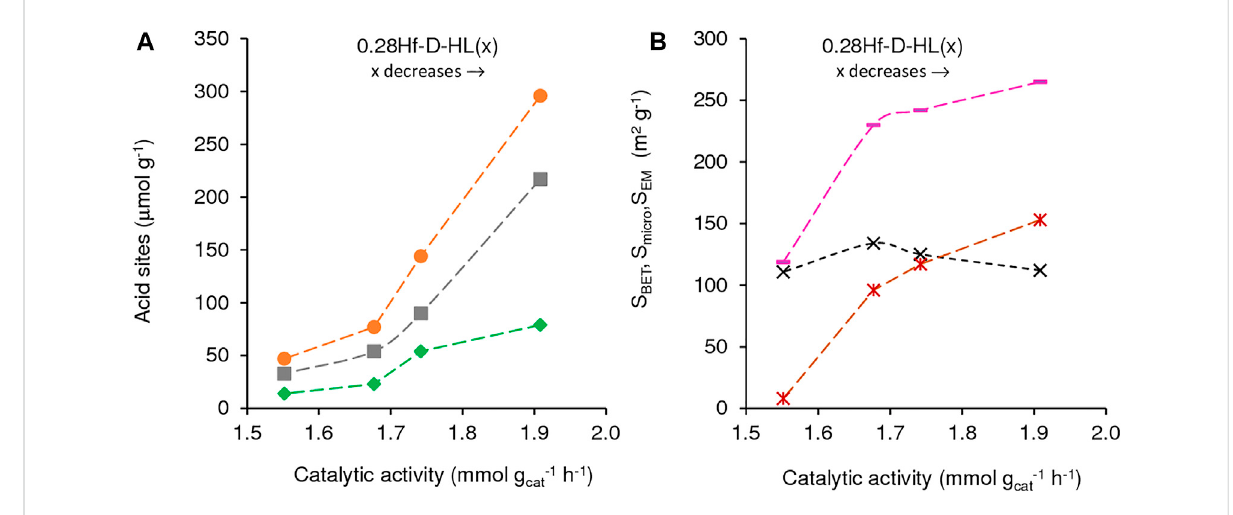
FIGURE 8 In fl uence of (A) the amount of acid sites (L ( ■ ), B ( ◆ ) and L + B ( 0.28Hf-D-HL(x) for LA conversion. Reaction conditions: 0.45 M LA in 2BuOH, 25.5 g cat L − 1 , 200 ° C, 5